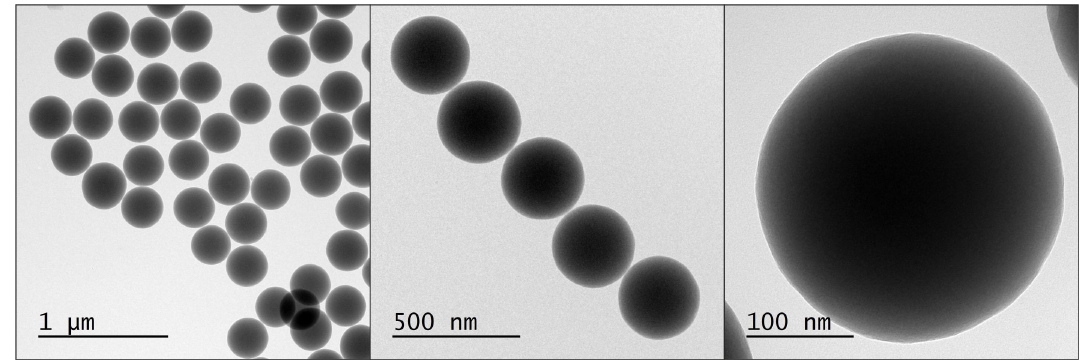
Figure 4. TEM micrographs of spherical silica prepared according to the Stöber